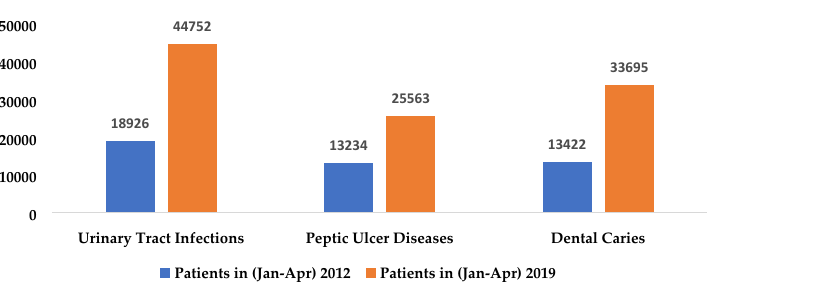
Figure 8. Water quality-related diseases in 2012 and 2019 in the Peshawar district. Source: Health Department of Khyber Pakhtunkhwa 55